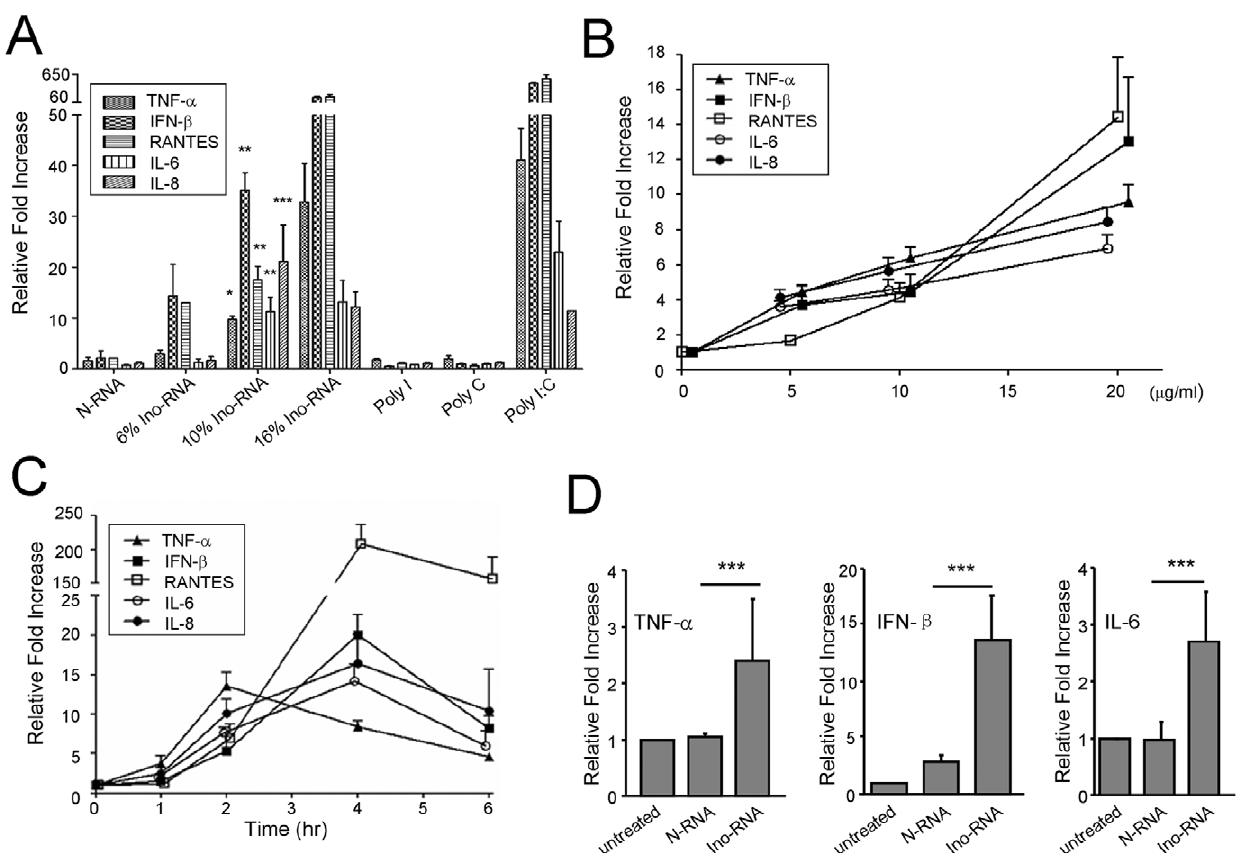
Figure 2. Ino-RNA activates primary human cells. Panel A , In vitro transcribed N-RNA and Ino-RNA (6%, 10% and 16% inosine content) were added directly to PHBE cells at 10 m g/ml final concentration. After 2 hr, total RNA was extracted and used in real-time RT-PCR (n $ 4). We next performed a concentration curve using Ino-RNA with 10% inosine content (2 hr, panel B, n=4) and kinetic studies ( panel C ) analysis of Ino-RNA induction of inflammatory cytokines (n=4). Panel D , treatment of primary human alveolar macrophages with N-RNA and 10% Ino-RNA (n $ 4). Error bars indicate standard error of the mean ( 6 SEM, *p , 0.05, **p , 0.01, ***p , 0.001).